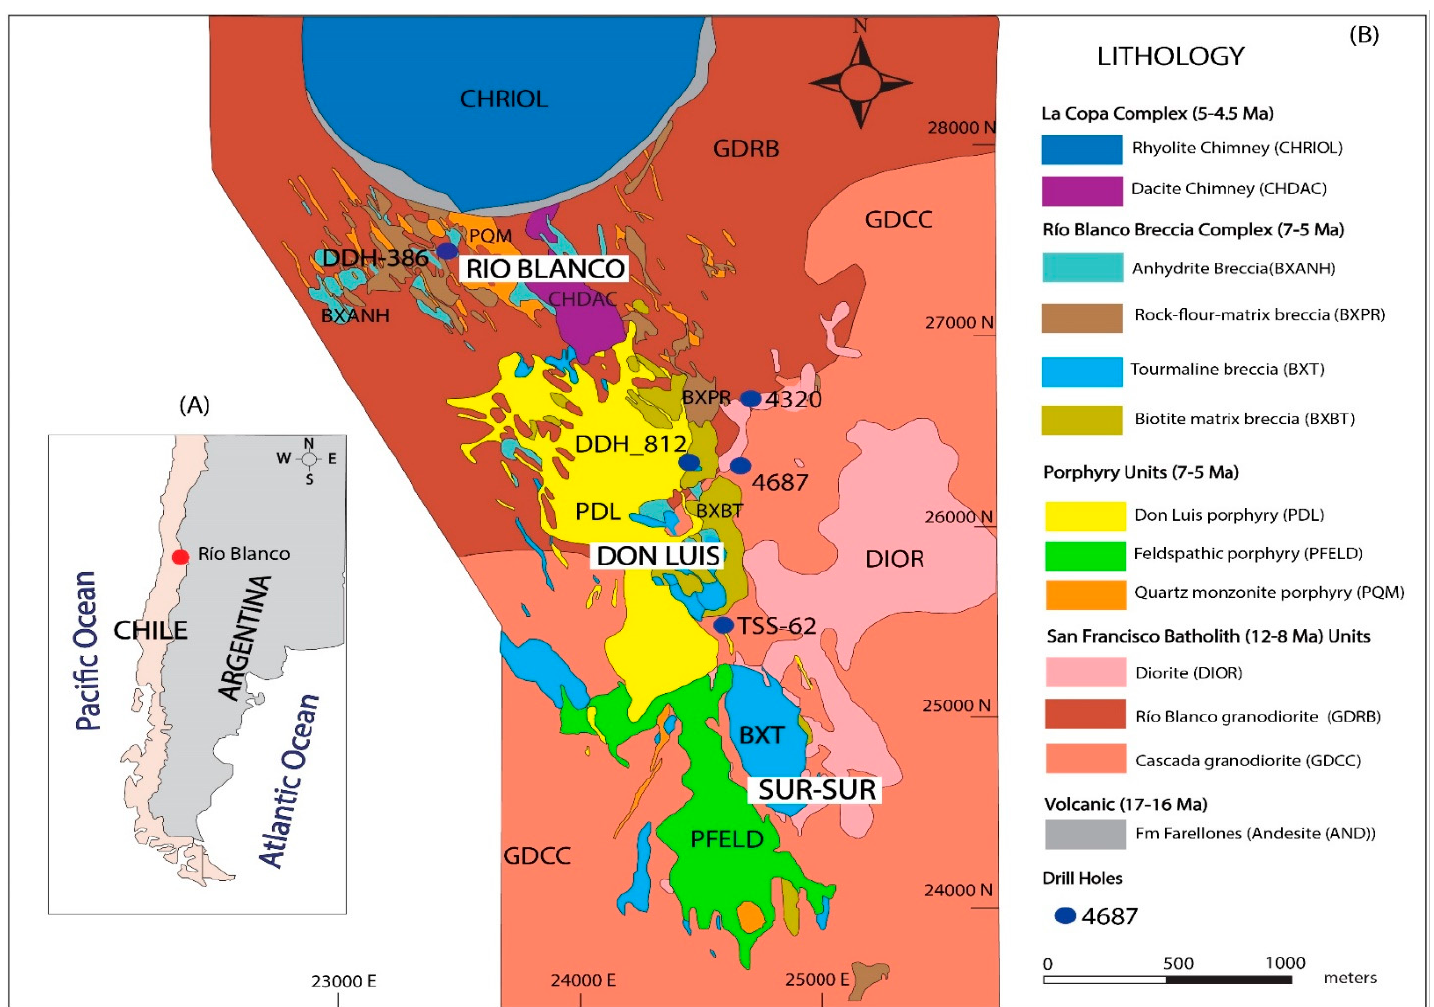
Figure 1. ( A ) Location of the Río Blanco porphyry Cu–Mo deposit in Central Chile. ( B ) Geology of the Río Blanco PCD, modified after Ferraz and Cruz 2011 [29].